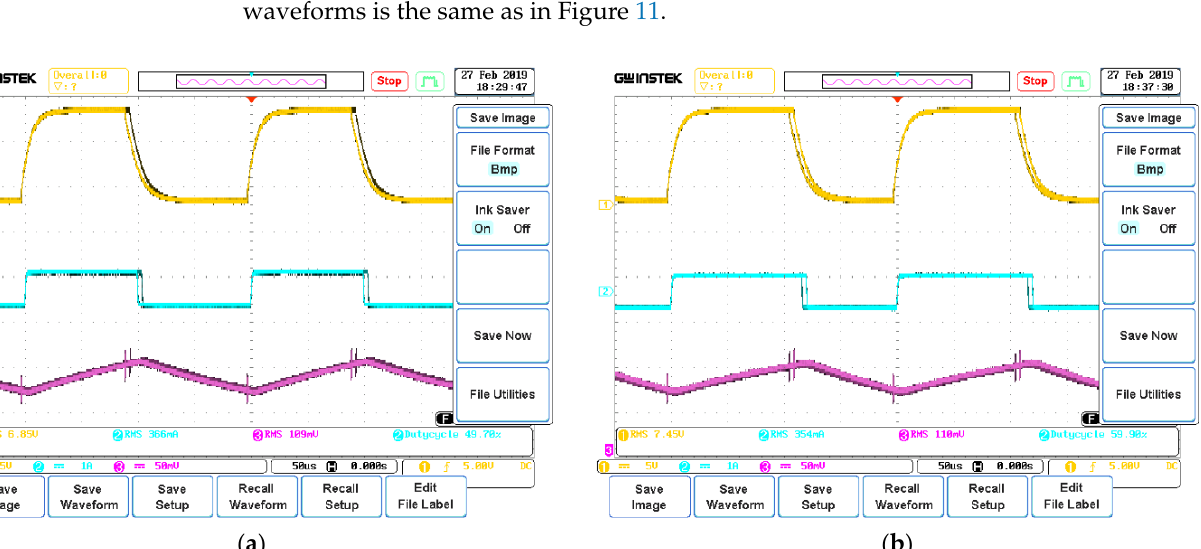
equal to 200 lx (a) or 100 lx (b), respectively. The convention for determining the appropriate